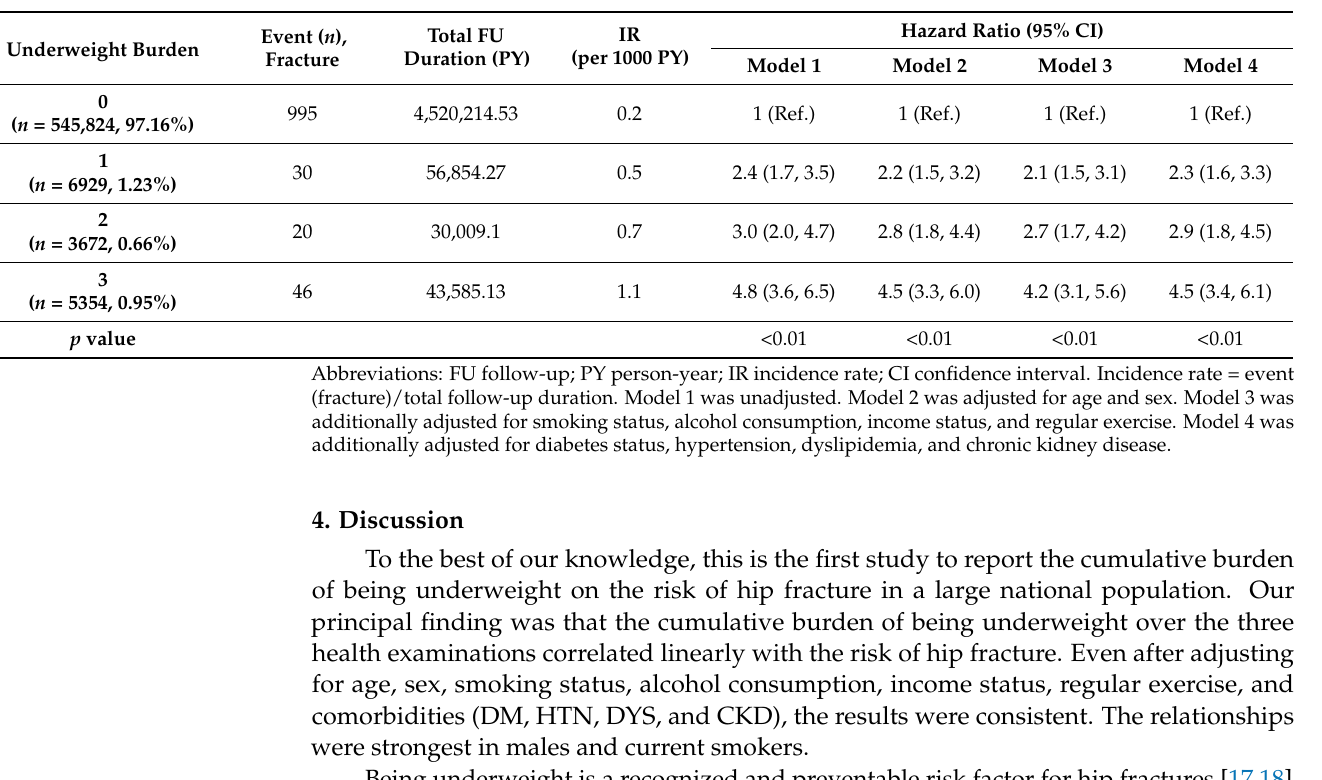
Table 3. The risk of hip fracture according to underweight